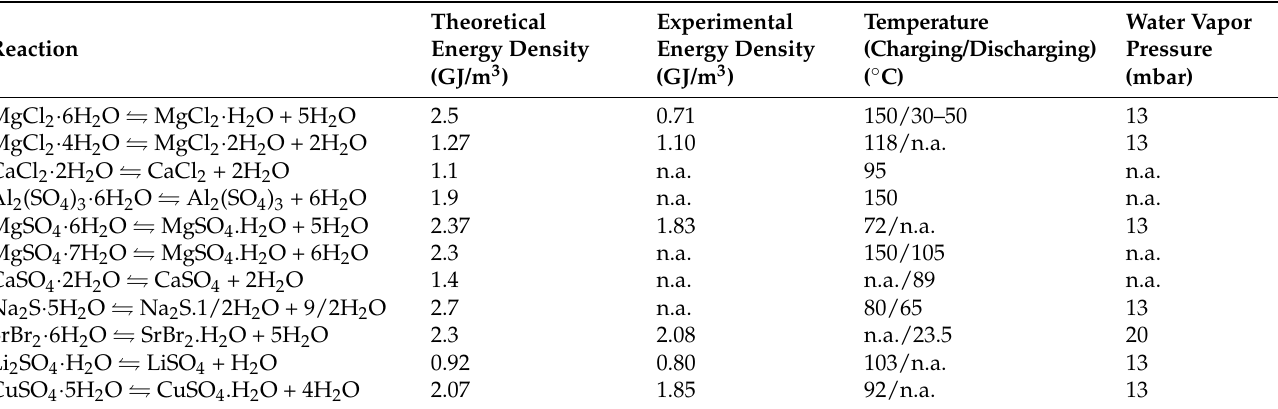
Table 1. Thermodynamic properties of some salt hydrates